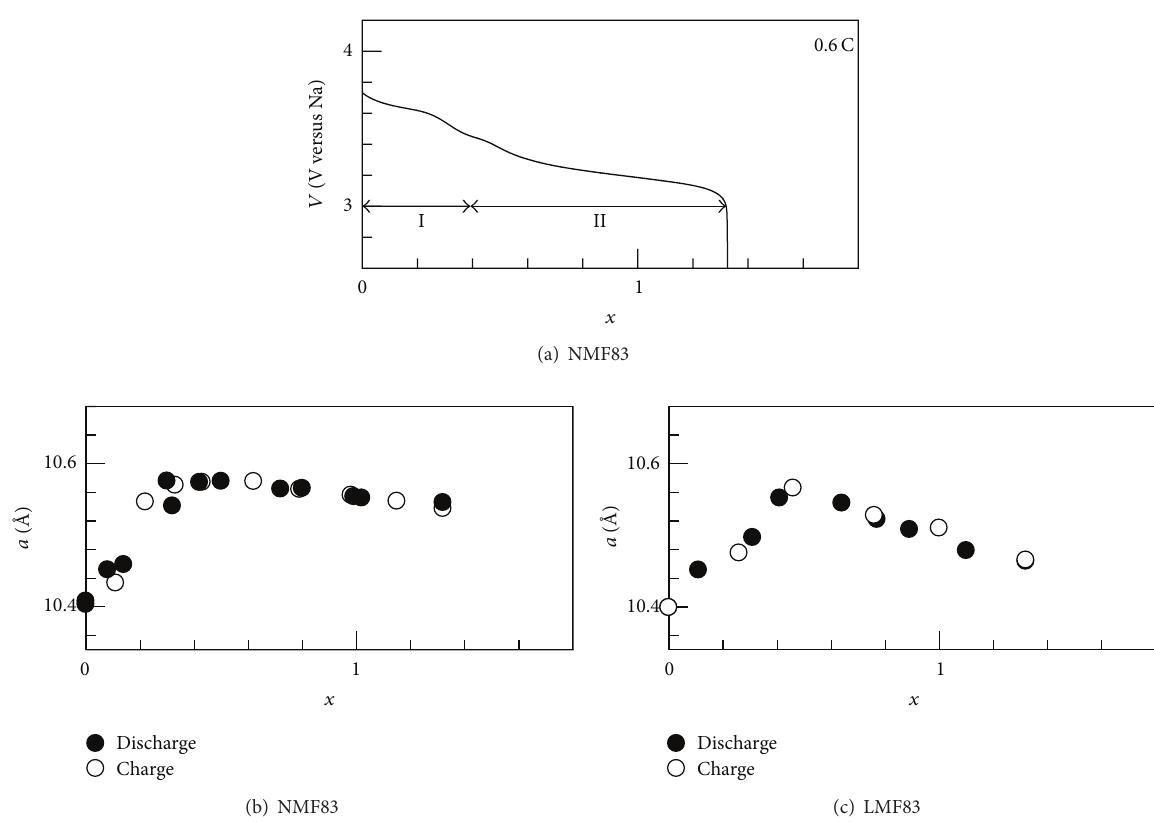
Figure 18: (a) Discharge curve, (b) lattice constant (a) of NMF83, and (c) lattice constant (a) of LMF83 against 𝑥 . Open (filled) marks in (b), and (c) mean that the data are obtained in the charge (discharge) run (cited from [14]).